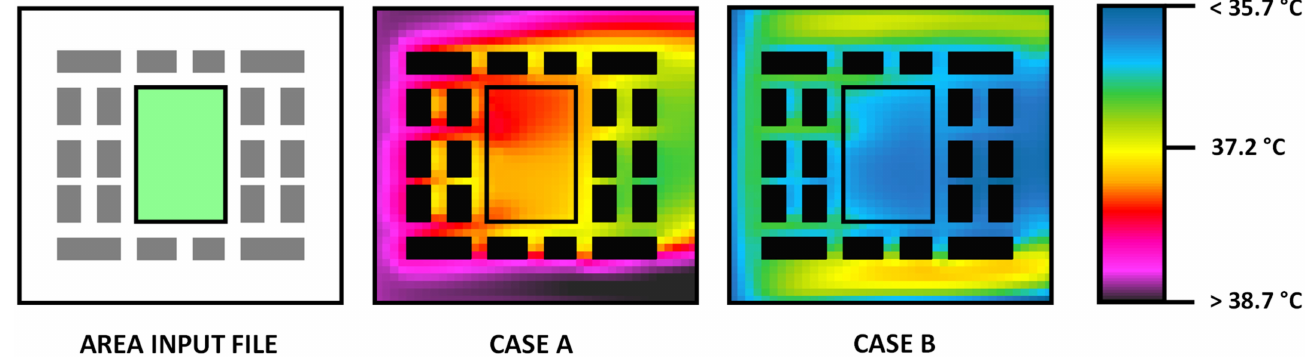
Figure 2. Starting from the left: the ENVI-met area input file followed by the temperature distribution calculated by the model at 2 m height at 13.00 for Case A (soil moisture equal to 21%) and for Case B (soil moisture equal to